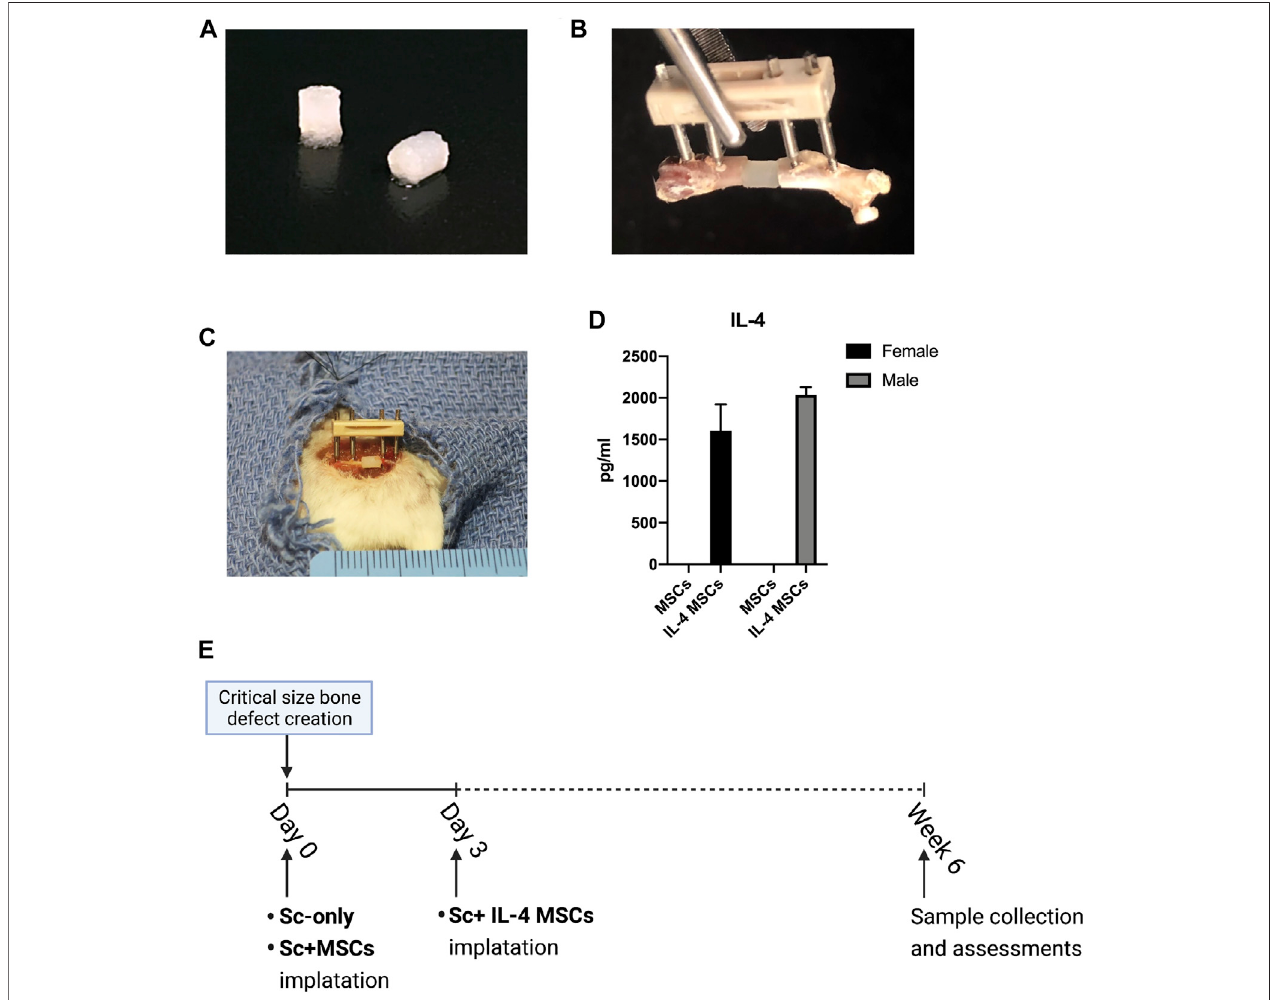
FIGURE 1 | Animal model and surgical procedure. (A) MSC-seeded μ RBs scaffolds. (B) A model of the external fi xator and μ RBs. (C) Implantation of a μ RBs scaffold in a mouse femur critical size bone defect with an external fi xator. (D) IL-4 secreting levels detected by ELISA in the culture media of IL-4 MSCs and MSCs for 24 h (2039.01 ± 90.73 pg/ml in male IL-4 MSCs and 1607.25 ± 313.58 pg/ml in female IL-4 MSCs. The IL-4 concentration could not be detected by ELISA in male and female MSC alone groups). (E) Surgical procedure. The IL-4 overexpressing MSCs (IL-4 MSCs) were added day 3 after creation of the surgical defect, whereas in the other groups, namely scaffold only (Sc-only), scaffold with unmodi fi ed MSCs (Sc + MSCs), were added immediately after the surgery (day 0).